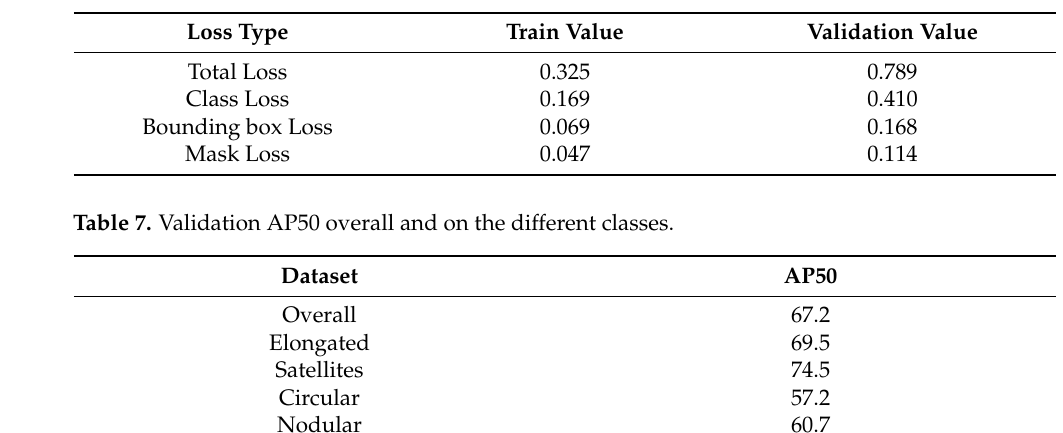
Table 6. Losses of the defined model.